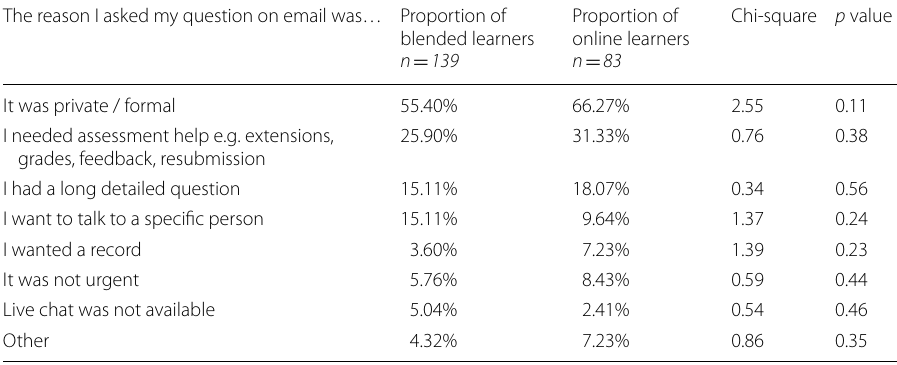
Table 8 Reasons online and blended learners used: email The reason I asked my question on email was… Proportion of